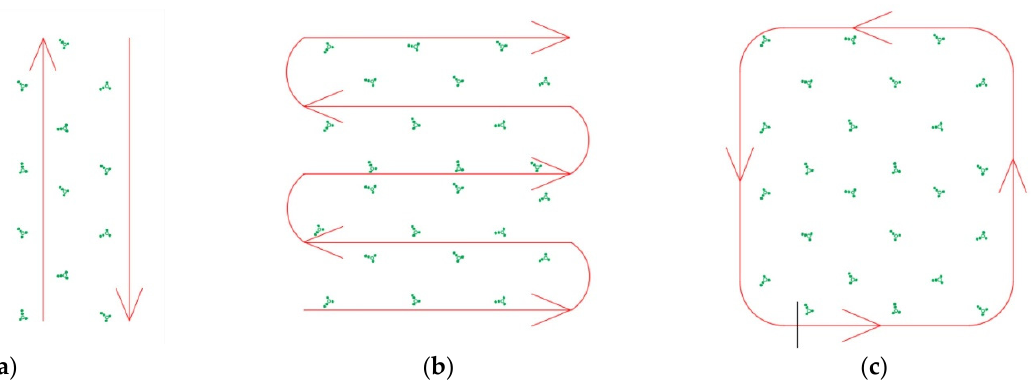
Figure 6. Path planning diagram. (( a ) shows a straight path; ( b ) shows an S-shaped path; ( c ) shows a circular path).